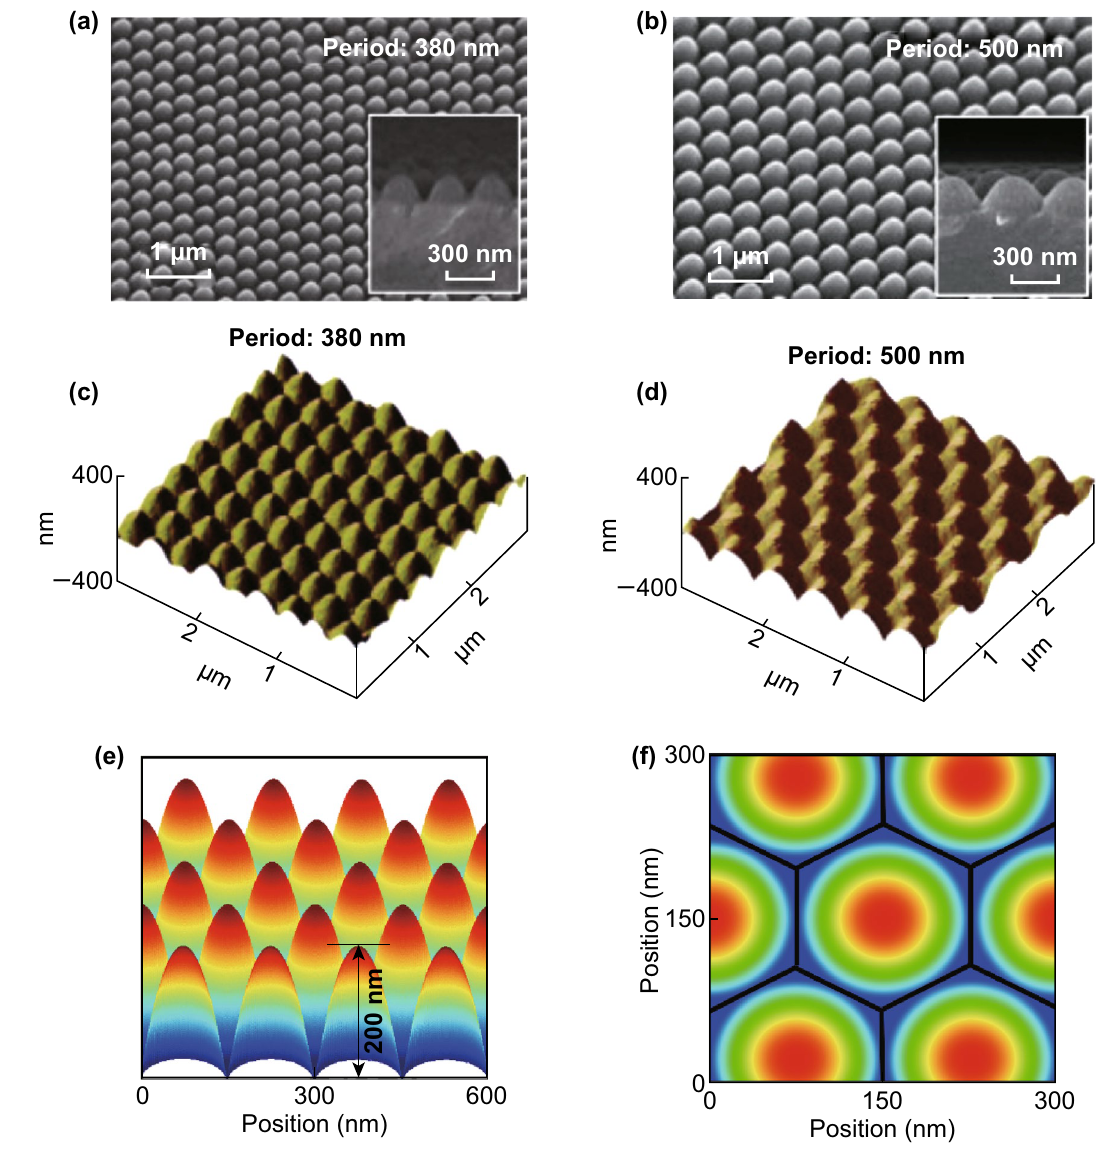
Fig. 12 a, b SEM and c, d AFM images of a moth eye surface texture. Reproduced with permission from Ref. [101]. Copyright 2019, Elsevier. e, f Moth eye surface texture used for the optical simulation of the solar